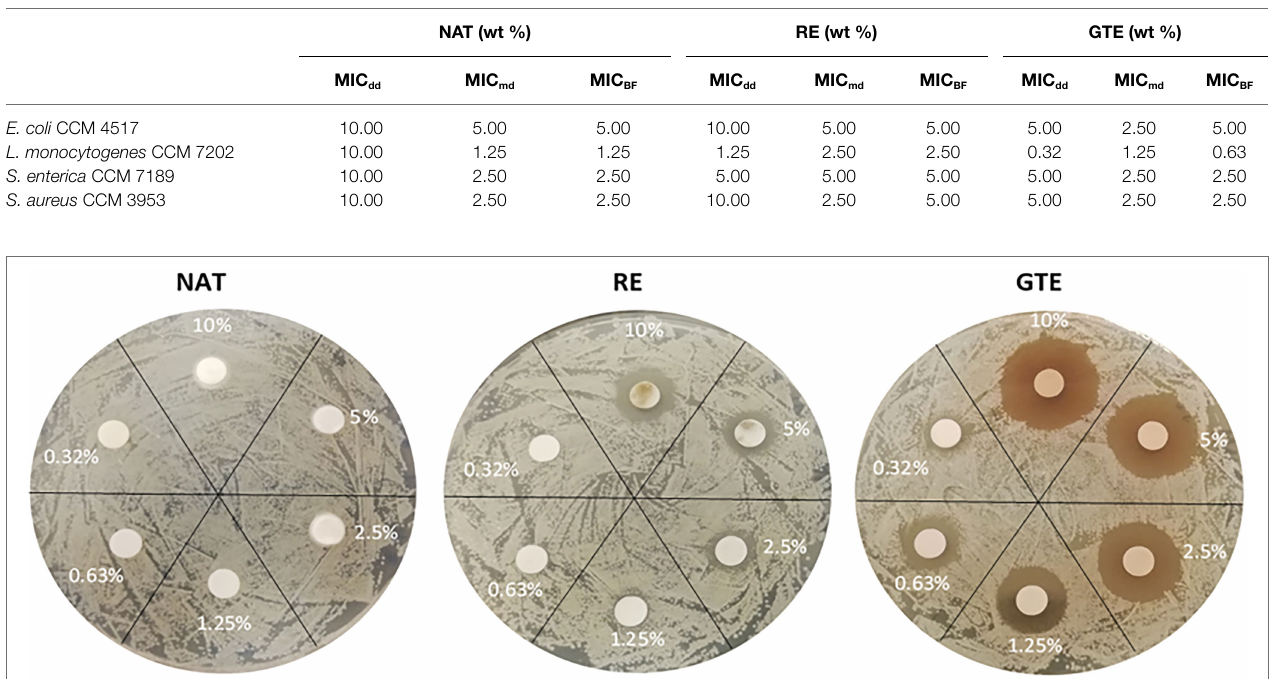
TABLE 2 | Determined MIC dd (minimal inhibitory concentration determined with disc diffusion method), MIC md (minimal inhibitory concentration determined with microdilution method), and MIC BF (minimal inhibitory concentration for biofilm formation) of NAT, RE, and GTE for Escherichia coli CCM 4517, L. monocytogenes CCM